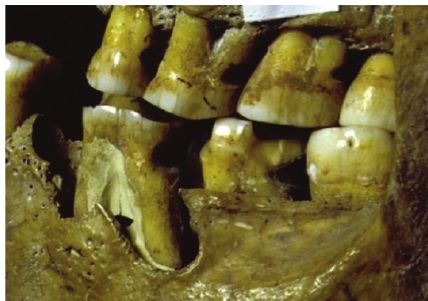
Figure 2: The passing of kangaroo tendon between posterior teeth caused distal abrasive wear called “interproximal grooving.”